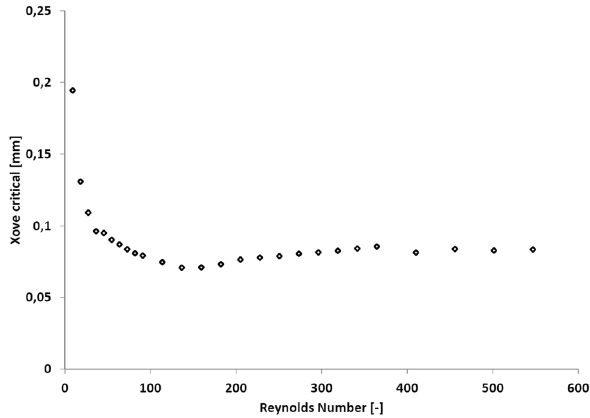
Fig. 11 Critical value of X H = 12 µm and p gap